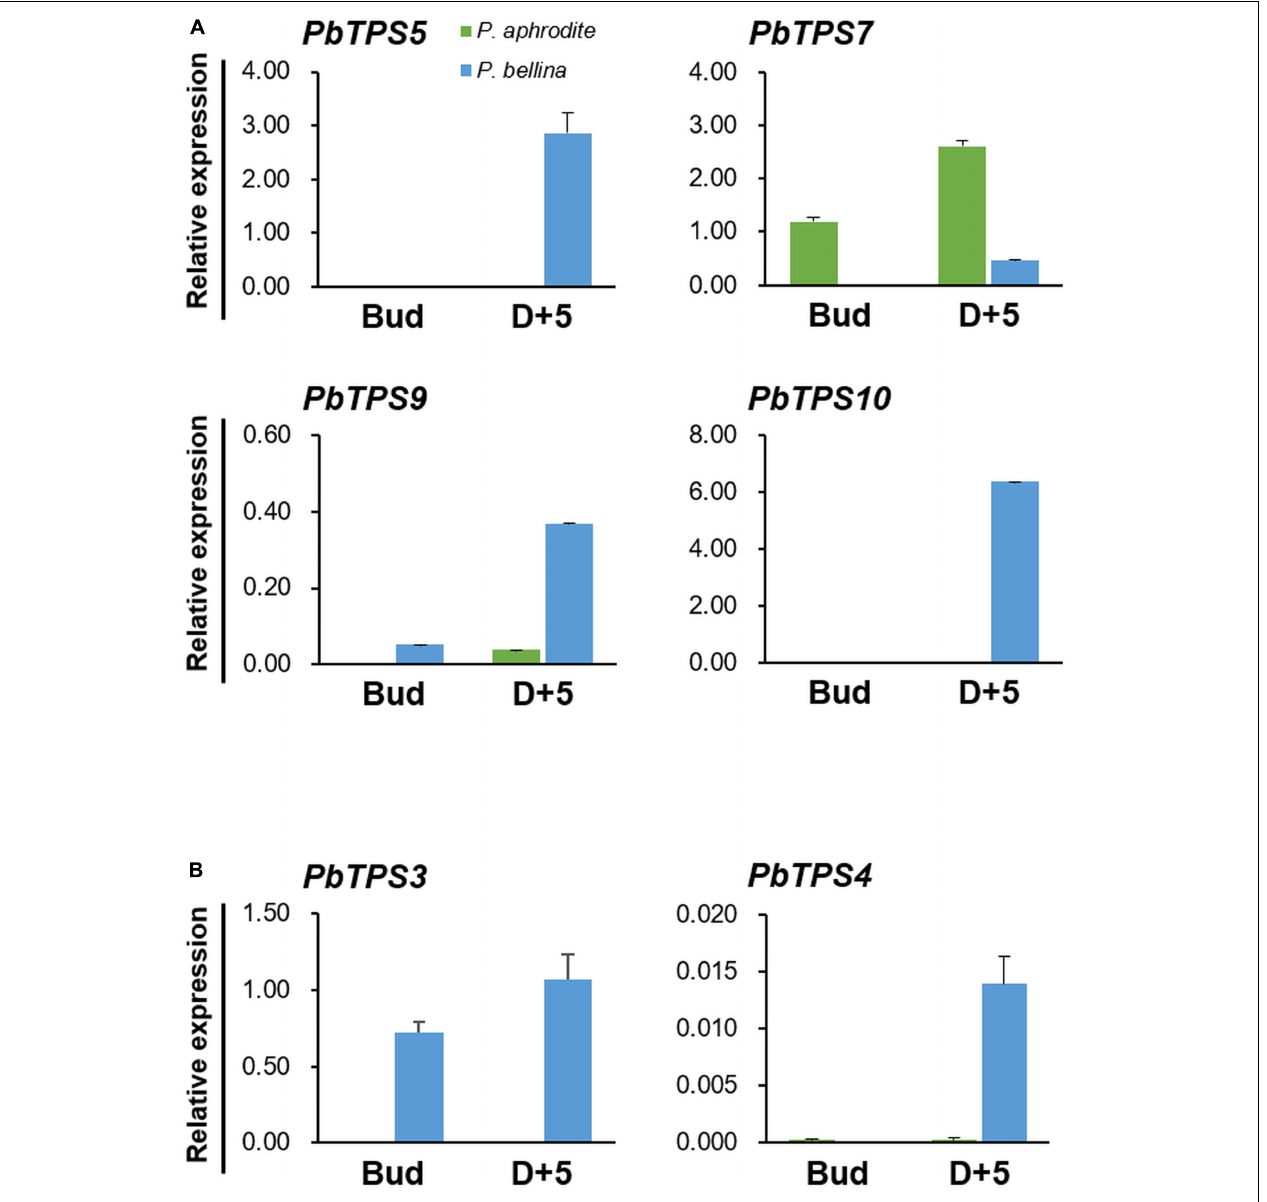
FIGURE 2 | Differential gene expression of PbTPSs between P. bellina and Phalaenopsis aphrodite . Panels (A,B) are the gene expression of TPS-b and TPS-e/f members, respectively. The expression of PbTPS s was analyzed at the floral bud stage (Bud) and 5 days after anthesis (D + 5). Green and blue column represent the expression of PbTPS s in Phalaenopsis aphrodite and P. bellina , respectively. Data were obtained from three independent experiments. The expression of all genes was normalized to the reference gene, PbActin1 (Chuang et al., 2018b). Calculation of mean and standard error was based on triplicate